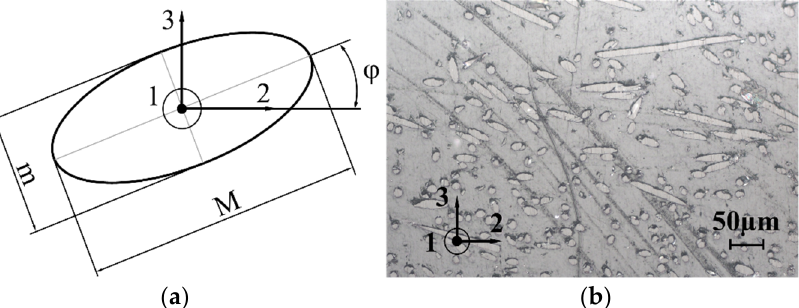
Figure 6. Explanation of measurement of fibre orientation in a section of one fibre, based on [16], ( a ) and one measured optical microscope image ( b ).